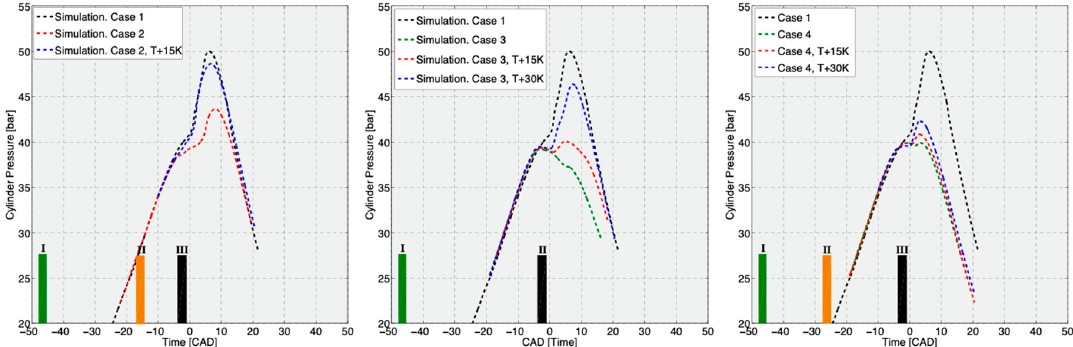
Figure 8. Predicted pressure traces for cases 1–4 at various adjusted initial temperatures.